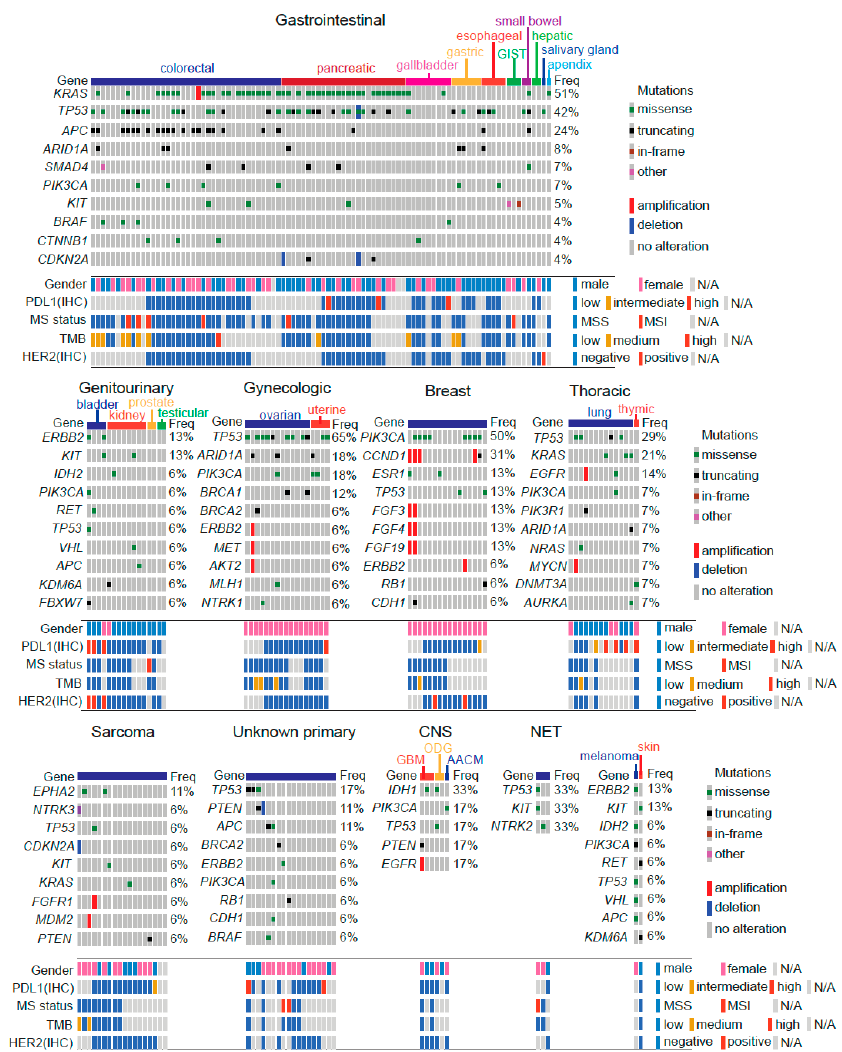
Figure 1. Mutational landscape of 202 Chilean advanced stage refractory cancer patients. Tumors were grouped as: gastrointestinal, genitourinary, gynecologic, breast, thoracic, sarcoma, unknown primary, central nervous system (CNS), neuroendocrine tumors (NET), melanoma and skin. Abbre- viations: GIST: gastrointestinal stromal tumor; MS: microsatellite; TMB: tumor mutational burden; GBM: glioblastoma multiforme; ODG: oligodendroglioma; AACM: anaplastic